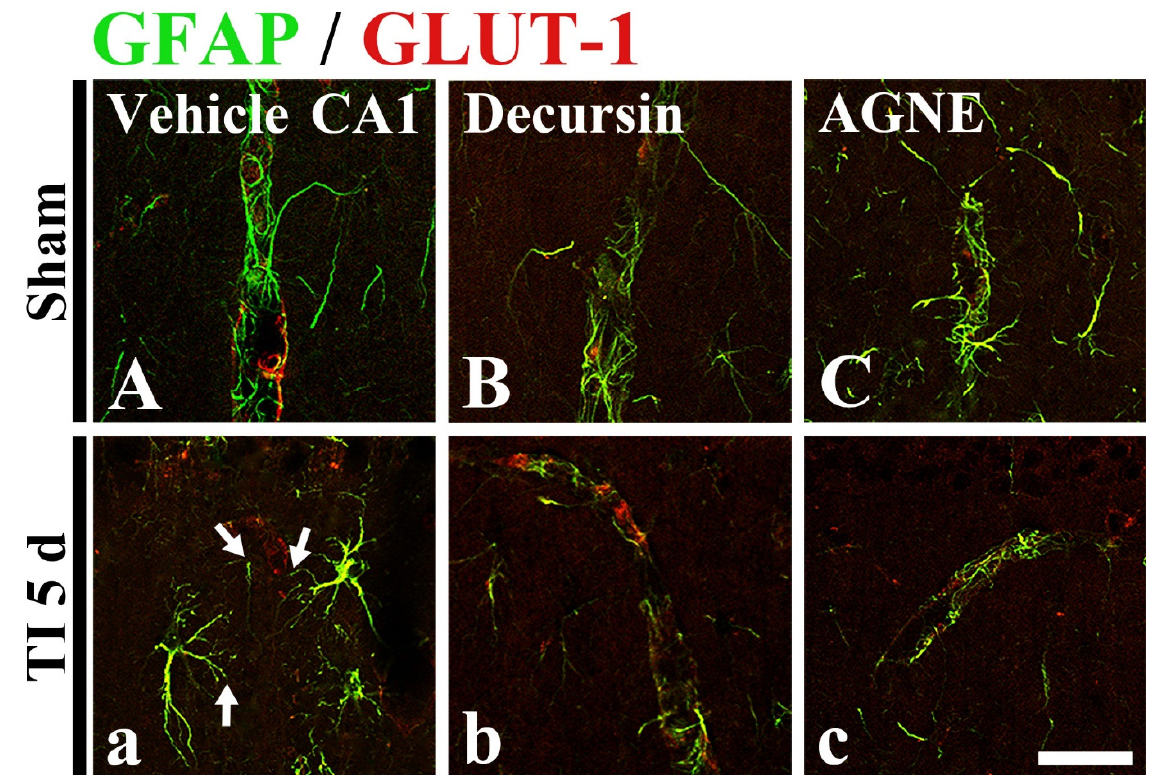
Figure 7. Double immunohistofluorescence for GFAP (green) and GLUT-1 (red) in CA1 of the sham groups ( A – C ), TI/vehicle ( a ), TI/decursin ( b ), and TI/AGNE ( c ) at 5 days after TI. In the TL/vehicle group, GFPA immunoreactive endfeet are damaged (arrows). In the TI/decursin and TI/AGNE groups, GFAP and GLUT-1 immunoreactive structures are well arranged like those in the sham groups. Scale bar = 50 μ m.